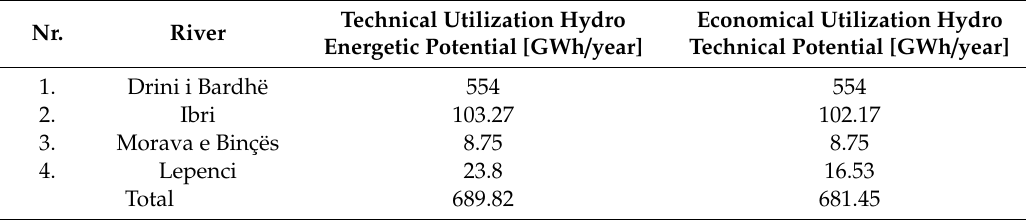
Figure 7. River basins and hydro meteorological stations in the Republic of Kosovo [21]. Table 5. Hydro energetic potential of Kosovo Rivers [21].